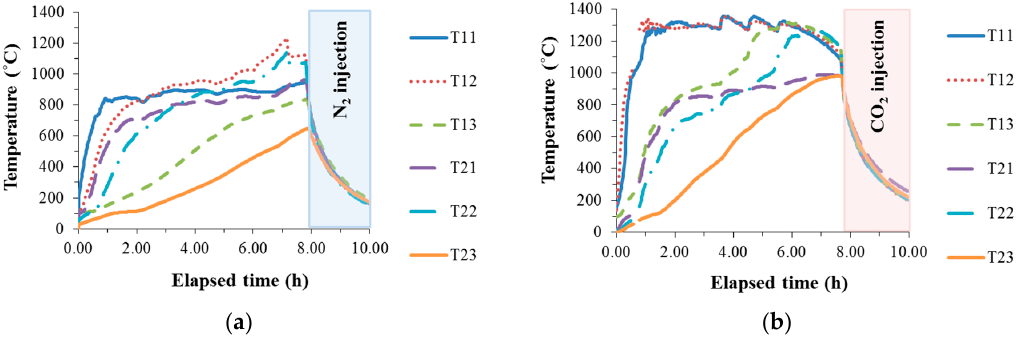
Figure 7. Temperature profiles: ( a ) Experiment 1; ( b ) Experiment 2.